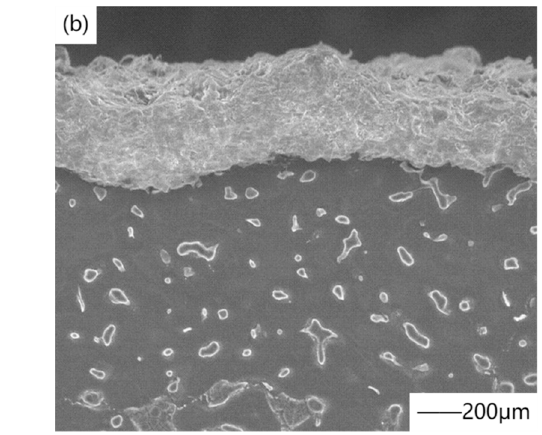
Figure 9. ( a ) Surface morphology of coating, ( b ) microstructure of coating section. Reprinted with permission from Ref. [82]. Copyright 2018 Copyright Elsevier.